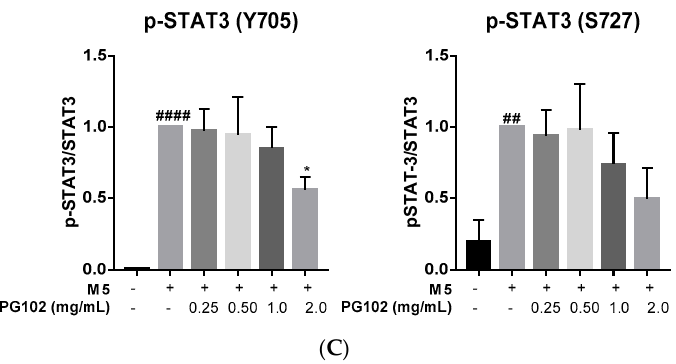
Figure 3. PG102 suppresses hyperproliferation of keratinocytes through STAT3 signaling. ( A ) WST-1 cell proliferation assay in HaCaT cells treated with M5 and PG102 for 24 h and 48 h ( n = 3). ( B ) PG102 was treated to M5-stimulated HaCaT cells for 30 min and Western blot analysis was performed. ( C ) Densitometry results of Western blot. The means of three independent experiments are shown. p-STAT3 (Y705), phospho-signal transducer and activator of transcription 3 (Tyr705). p-STAT3 (S727), phospho-signal transducer and activator of transcription 3 (phospho S727). ## p < 0.01, #### p < 0.0001 versus Control group; * p < 0.05, ** p < 0.01 versus M5-only treated group. The data are shown as the mean ± standard error (SD).